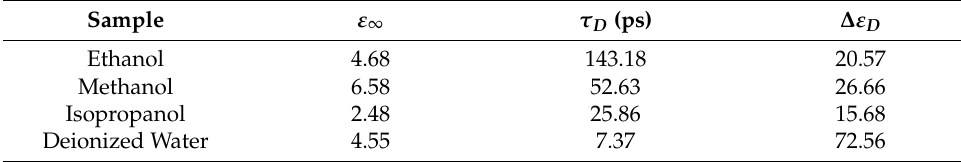
Figure 8. Measured transmission response of different liquid sample (isopropanol (IPA), ethanol, methanol and deionized water). Table 2. The Debye model parameters of different liquid.